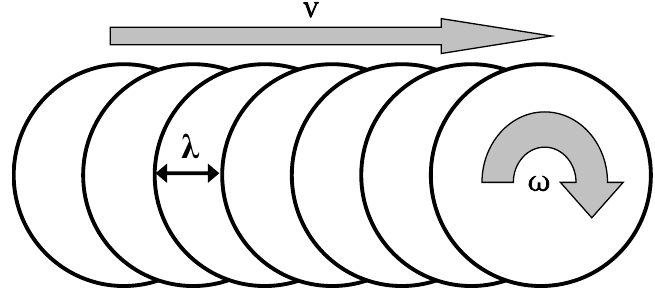
Figure 5. Schematic of the advancing pitch.